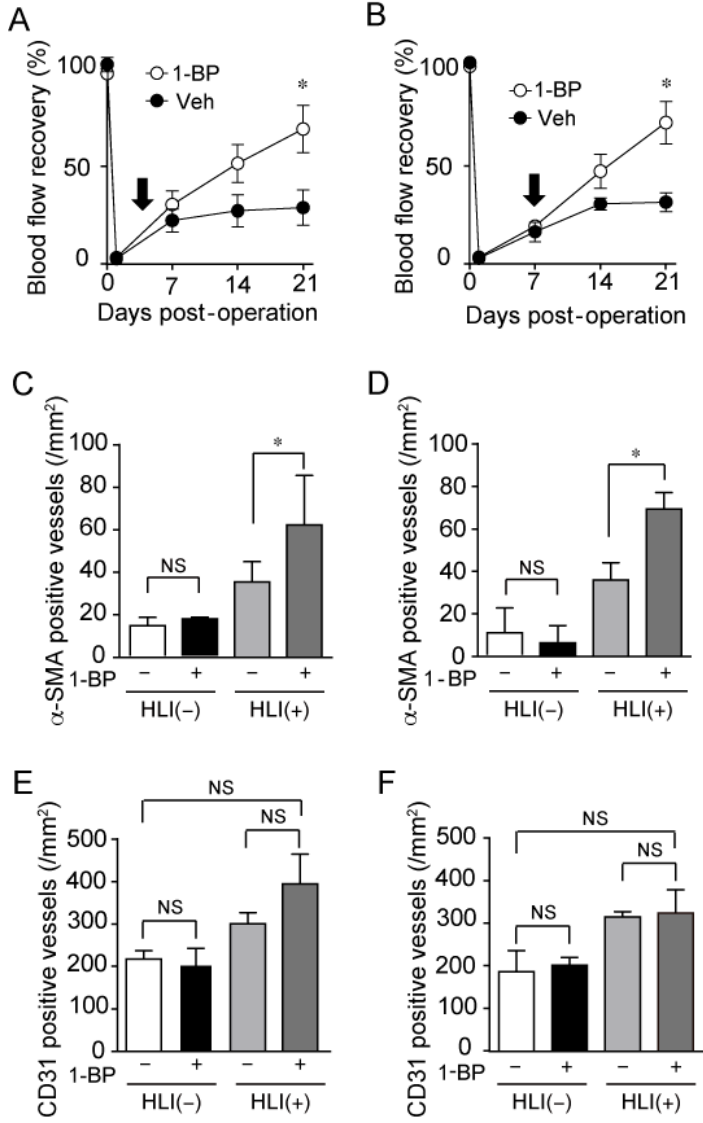
Figure 8. Treatment with 1-BP after HLI also promotes arteriogenesis and blood flow recovery. ( A , B ) Averaged time courses of blood flow recovery in mice treated with 1-BP or vehicle (Veh) after HLI. Osmotic pump including 1-BP (0.1 mg/kg/day) was implanted at 3 days ( A ) and 7 days after HLI ( B ), as shown by arrows (n = 8 mice). ( C – F ) Quantitative results of the number of α -SMA positive vessels ( C , D ) and CD31 positive vessels ( E , F ) at 3 weeks after HLI. (n = 3 mice). ( C , E ) 1-BP was administered from 3 days after HLI. ( D , F ) 1-BP was administered from 7 days after HLI. Data are mean ± s.e.m. ( A , B ) or median with 95% CI ( C – F ). * p < 0.05, NS.; no significance. Comparisons were made using Two-way ANOVA ( A , B ) or Kruskal-Wallis test ( C – F